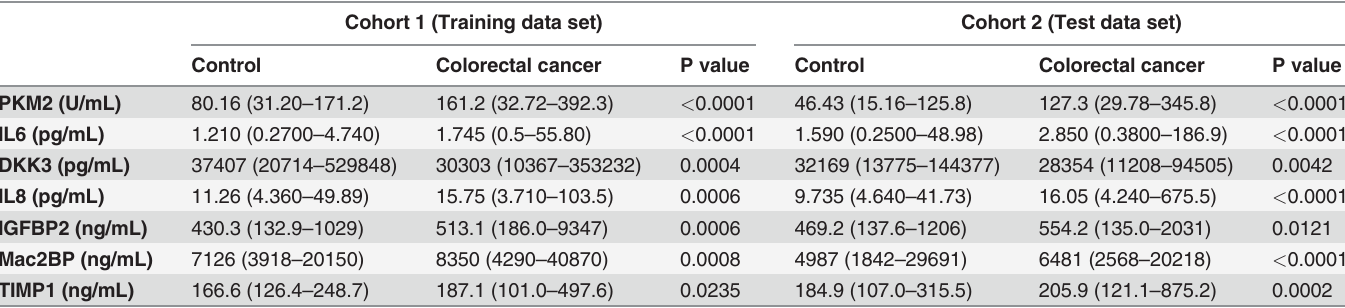
Table 2. Concentration (median and range) for individual protein biomarkers measured in the serum of cancer and control patients. Cohort 1 (Training data set) Cohort 2 (Test data